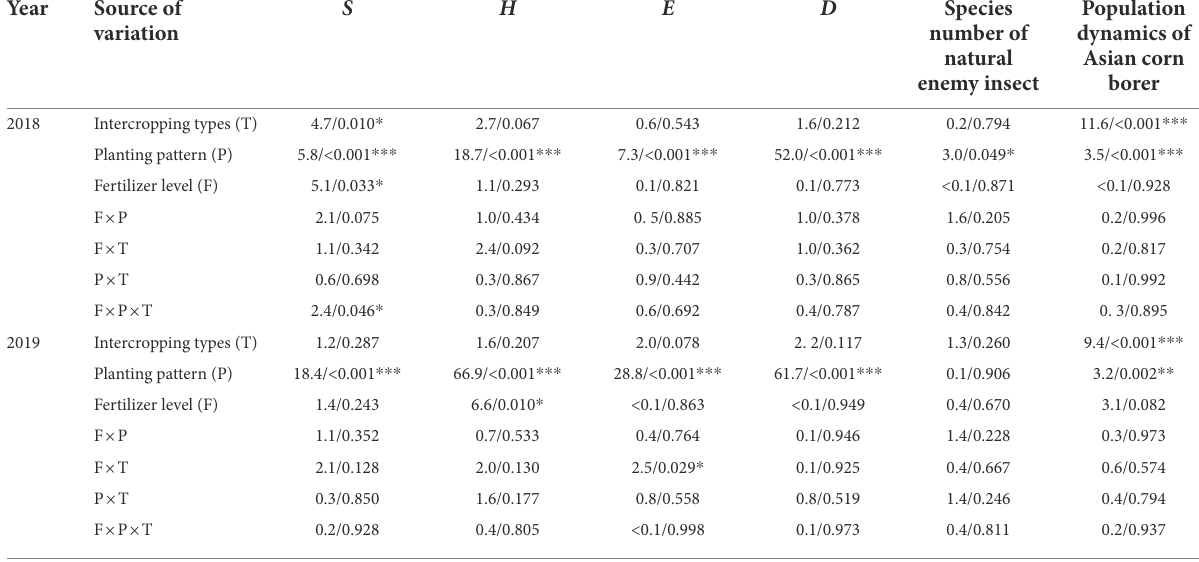
TABLE 2 Three-way repeated-measured analysis of variance (ANOVA) on the effects of intercropping type (T; corn–soybean/peanut/millet intercropping), planting patterns (P; corn monoculture and three planting patterns of corn intercropping with soybean/peanut/millet, respectively), fertilizer level (F; normal vs. reduced), and their bi-/tri-interactions on the community diversity indexes of insects, number of natural enemy insect species on corn plants, and three-way ANOVA on the population dynamics of Asian corn borer per 30 corn plants in 2018 and 2019 ( F/p